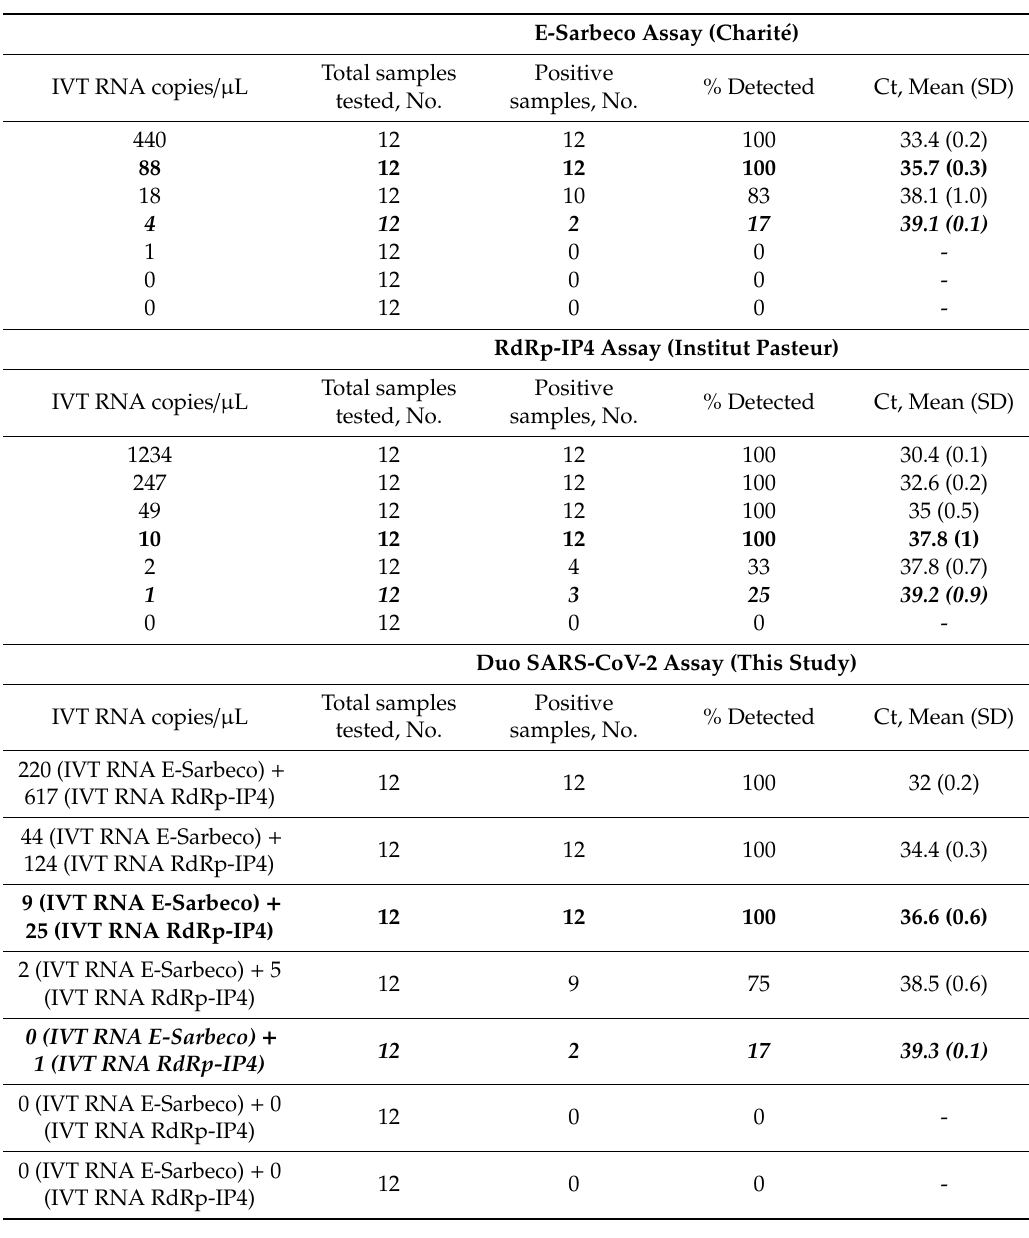
Table 2. Analytical sensitivity of E-Sarbeco (Charit é ), RdRp-IP4 (Institut Pasteur) and duo SARS-CoV-2 assays. In bold, lowest RNA copy number providing 12 / 12 positive results; in italicized bold, lowest RNA copy number providing at least 1 / 12 positive